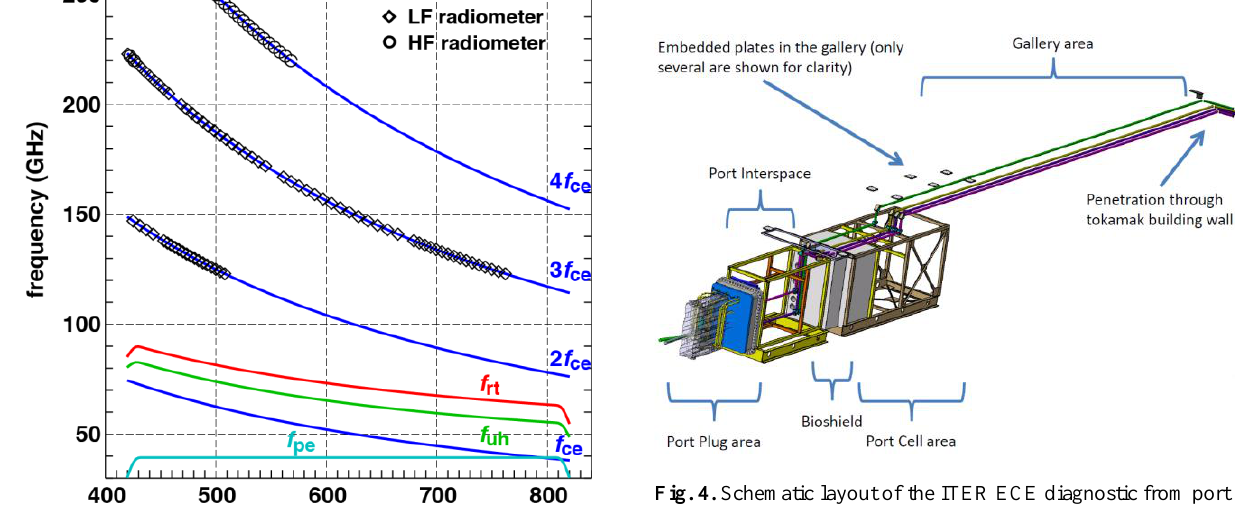
Fig. 4. Schematic layout of the ITER ECE diagnostic from port plug to the tokamak building boundary.